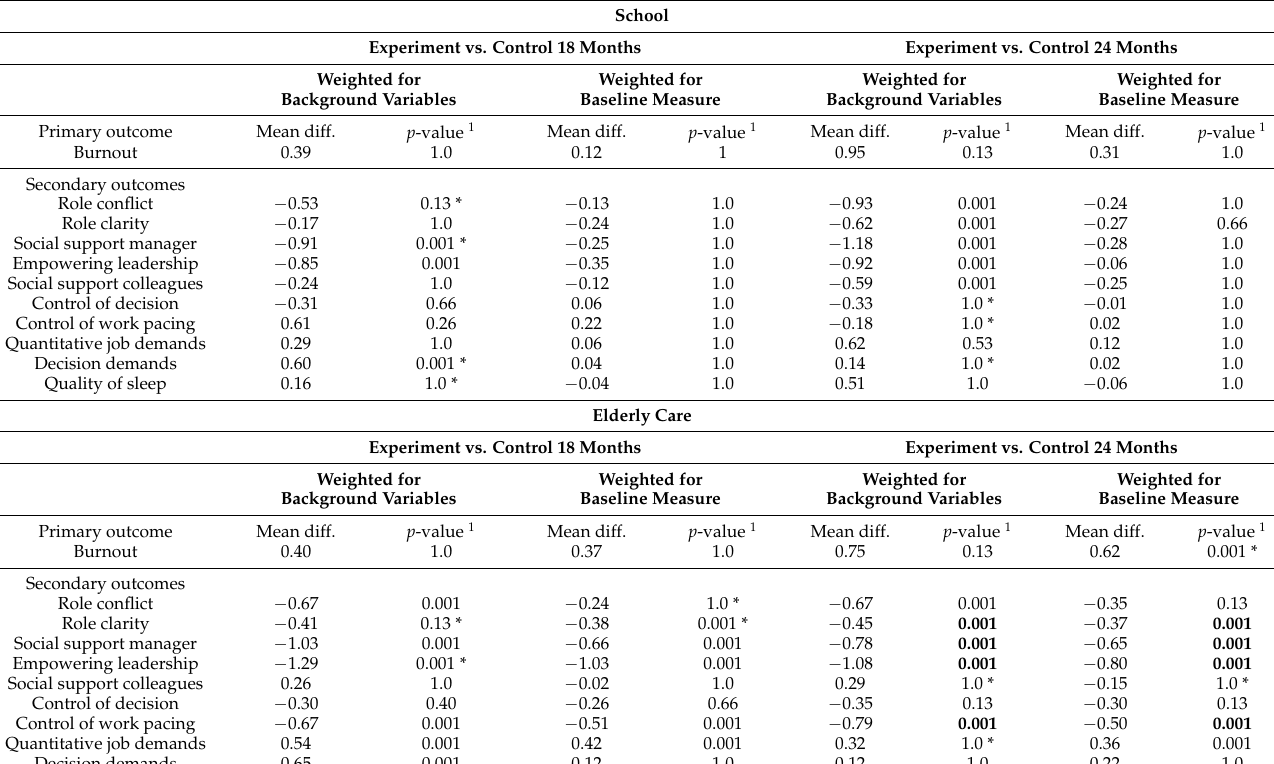
Table 4. Between group differences at second and third follow-up.